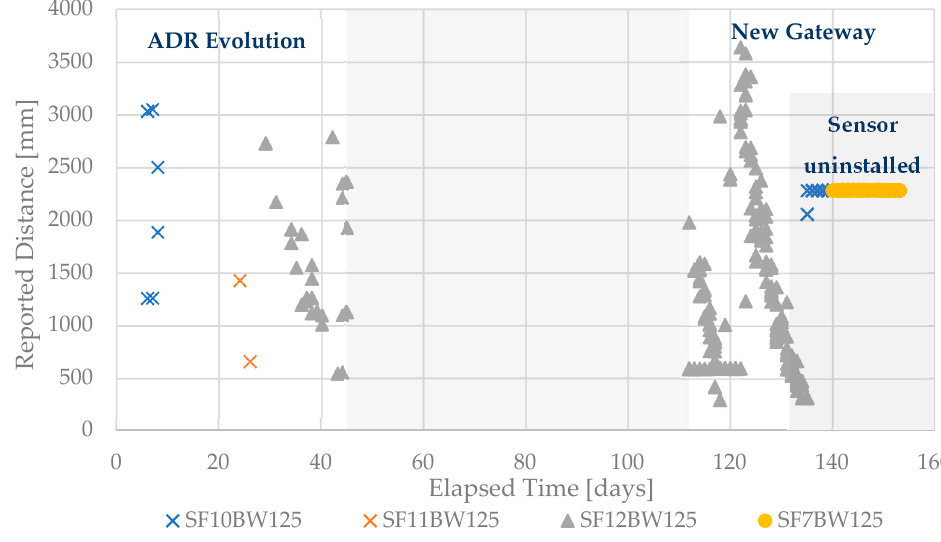
Figure 13. Measurements received from the underground container at Spacio Shoping.